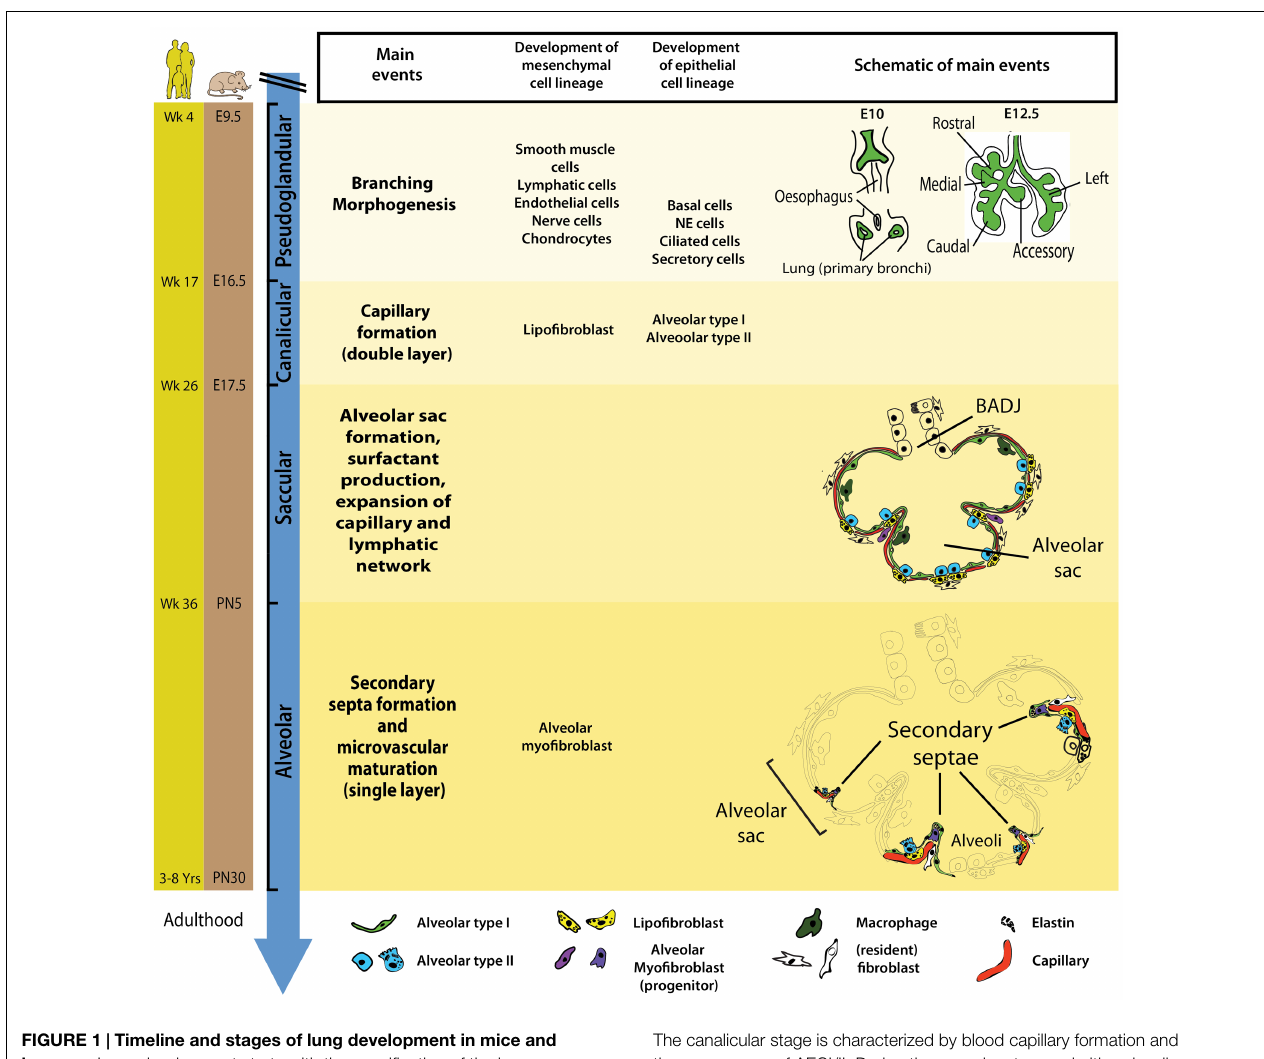
FIGURE 1 | Timeline and stages of lung development in mice and humans . Lung development starts with the specification of the lung domain in the foregut endoderm followed by the formation of primary lung buds. These buds will later give rise to the respiratory tree via the process of branching morphogenesis. The latter is a characteristic of the pseudoglandular stage of lung development. Most epithelial and mesenchymal cell types start to form during the pseudoglandular stage.